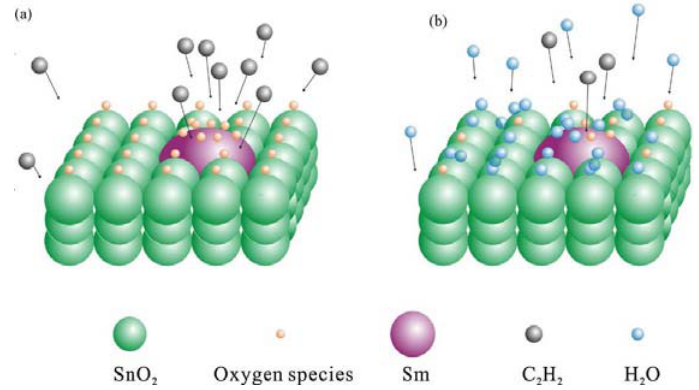
H and humidity (adapted from 2 2